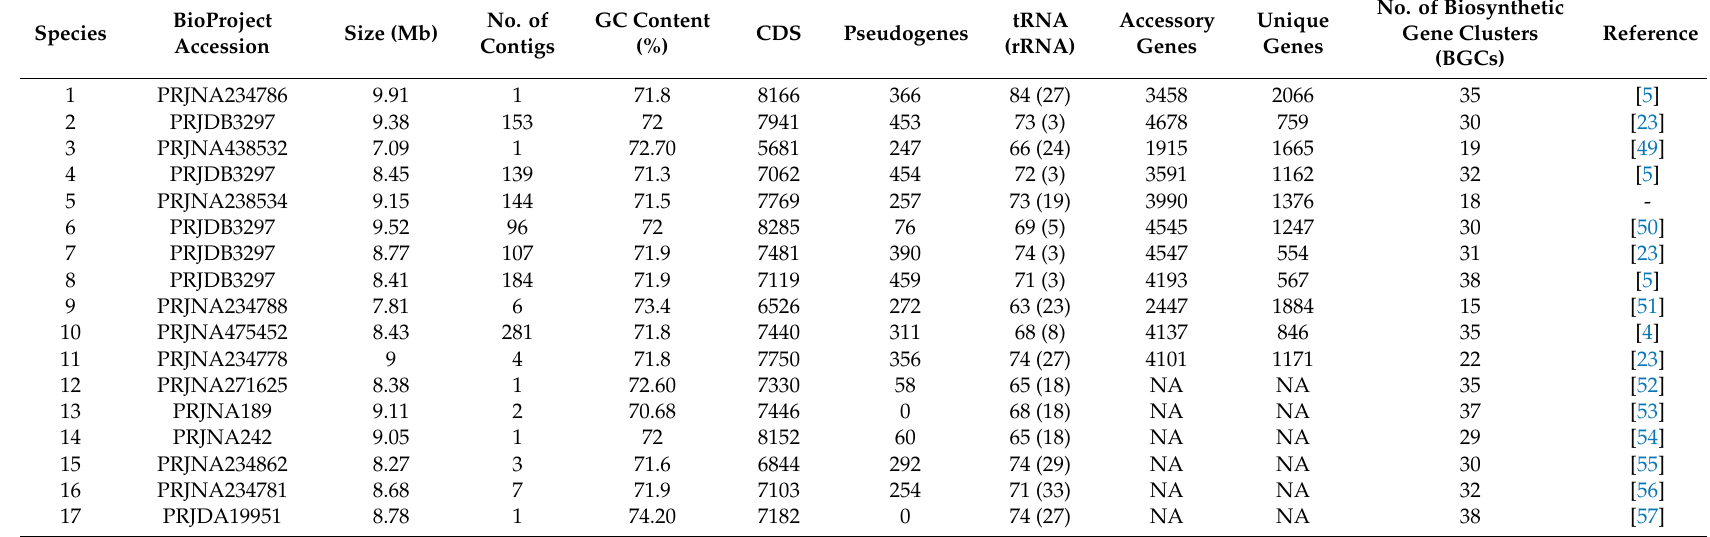
Table 1. Features of 11 Streptacidiphilus genomes and their comparison with representatives from Streptomyces and Kitasatospora. Species: 1, Streptacidiphilus albus JL83 T ; 2, Streptacidiphilus anmyonensis NBRC 103185 T ; 3, Streptacidiphilus bronchialis DSM 106435 T ; 4, Streptacidiphilus carbonis NBRC 100919 T ; 5, Streptacidiphilus